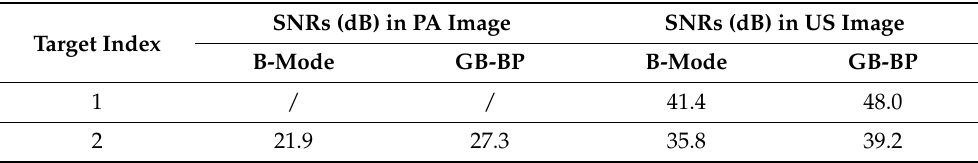
Table 2. The extracted FWHMs of the lateral profiles for two targets.